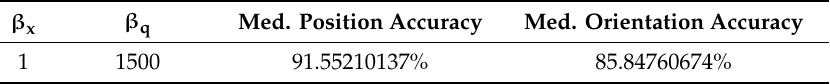
Table 9. Accuracy of the weighted Euclidean-based model (30,000 iterations).